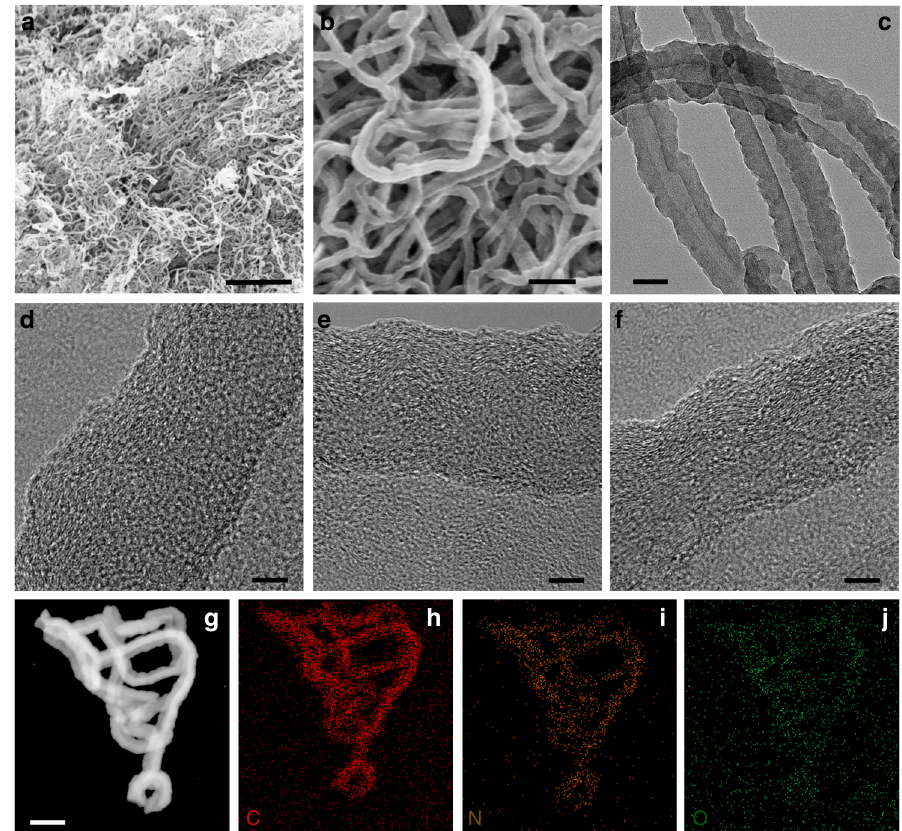
Fig. 1 Structure characterizations of NCNFs by electron microscopies. a , b SEM and c TEM images of NCNF-650. HRTEM images of NCNF-650 ( d ), NCNF- 950 ( e ), and NCNF-1100 ( f ). g – j Images of element mapping of C, N, and O for NCNF-650. Scale bars: 2 µ m ( a ); 200 nm ( b ); 50 nm ( c ); 5 nm ( d – f ); 100 nm ( g (Fig. 1e) and NCNF-1100 (Fig. 1f) become progressively ordered with the graphene layers being less curved and more aligned, which reveals the graphitizable nature of the soft carbons.